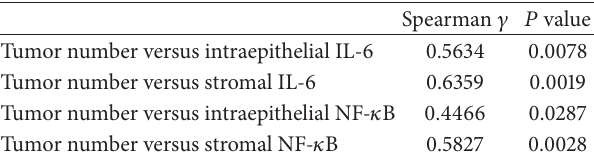
Table 1: Correlations between tumor number and densities of IL-6 and NF- 𝜅 B positive